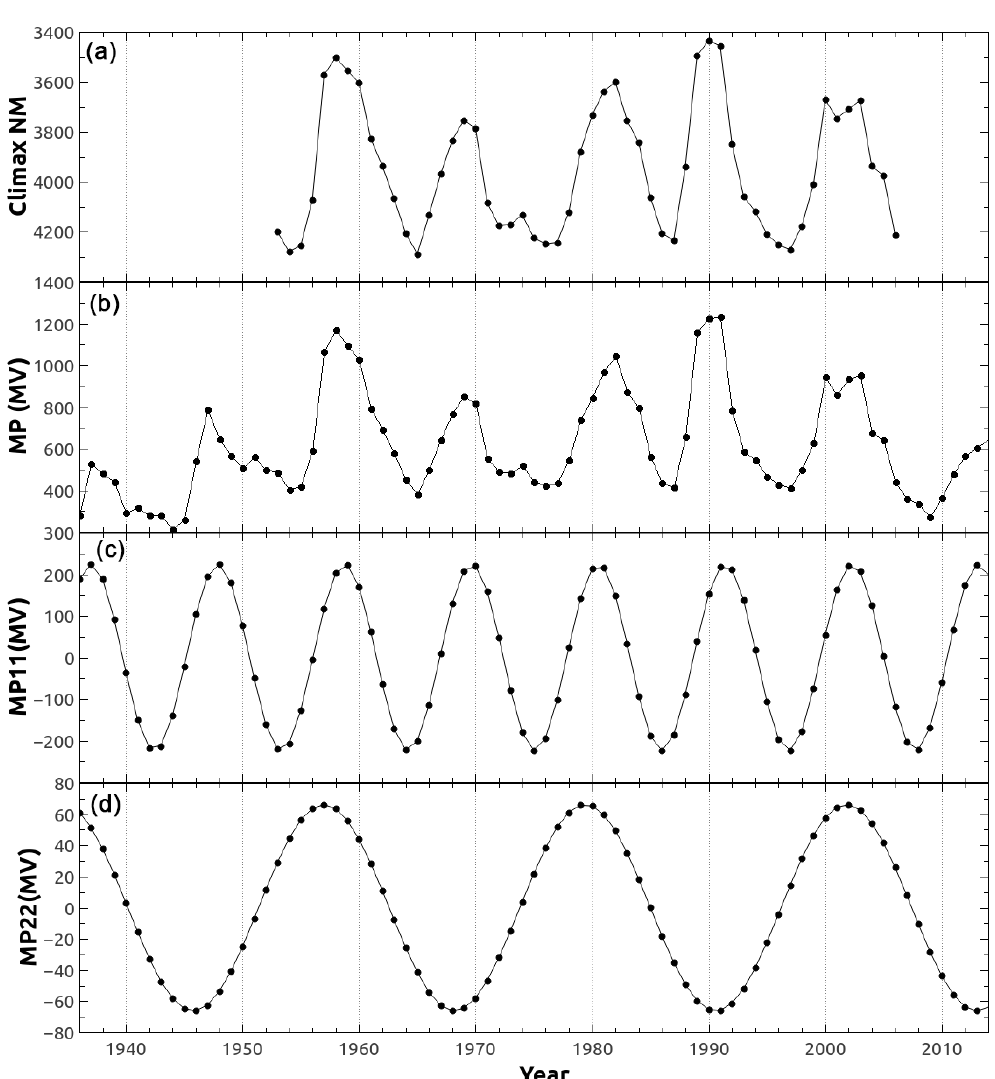
Figure 3. (a) Time series of yearly neutron counts at the Climax Observatory, (b) the modulation potential, (c) the approximately 11-year component of the modulation potential, and (d) the approximately 22-year component of the modulation potential. Note that the vertical scale of (a) is inverted to facilitate a comparison with (b)